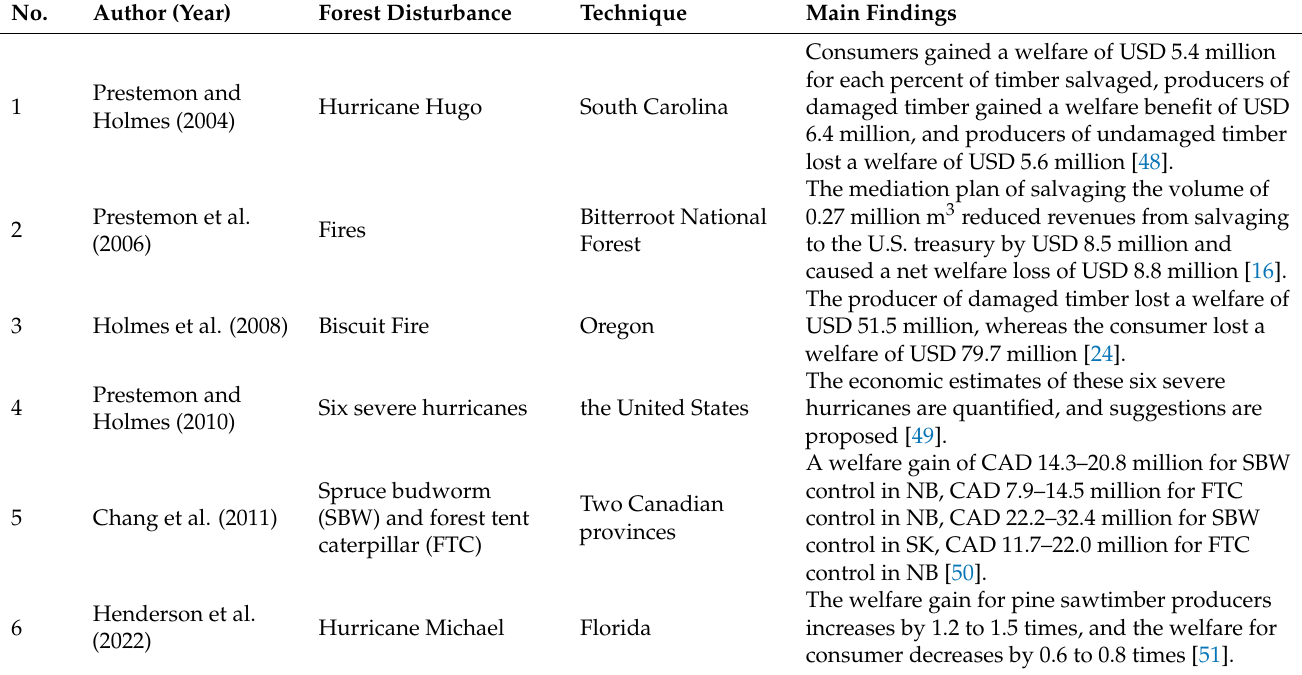
Table 6. Summaries of literature using the social welfare